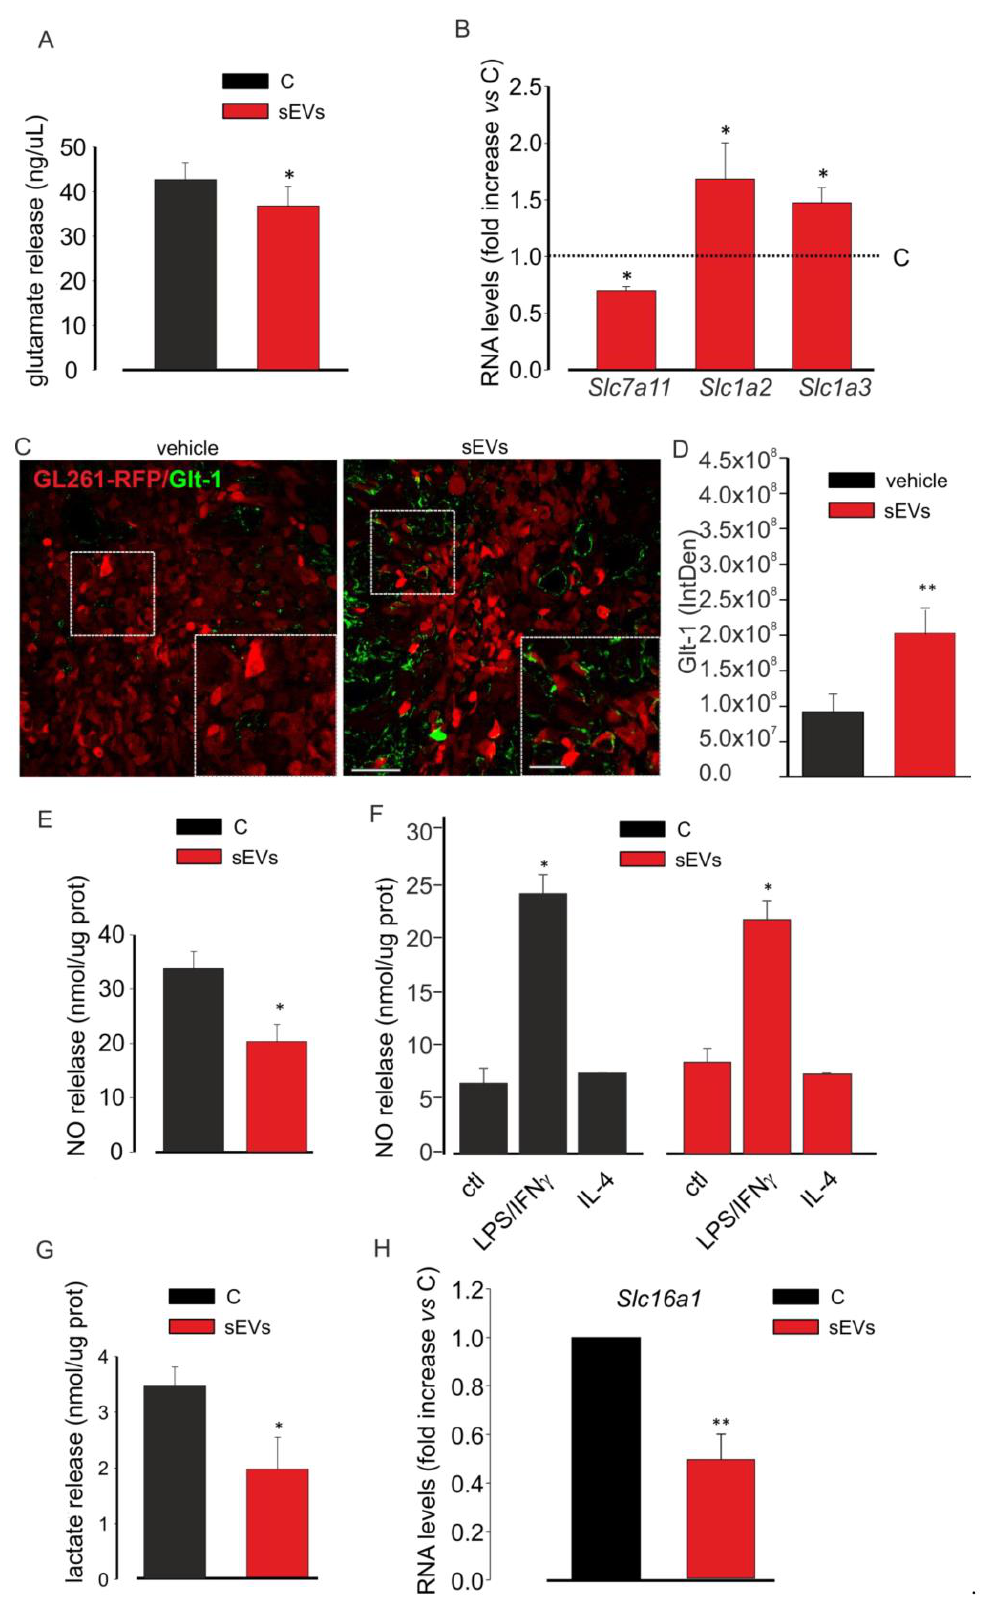
Figure 4. Microglia-derived sEV effects on the toxicity of glioma cells. ( A ) Glutamate release in a medium of untreated (C) or BV2-derived sEVs-treated GL261 cells. Data are expressed as ng/mL; N = 3; * p < 0.05 vs. C; by using Student’s t